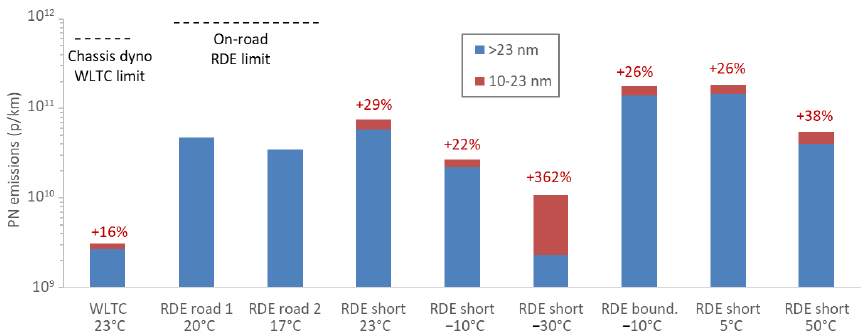
Figure 1. Particle number (PN) emissions for various cycles and ambient temperatures (in chronological order): Type 1 (WLTC), Type 1A on-road RDE (RDE road), RDE-like cycles tested on the chassis dynamometer (RDE short, RDE boundary). Dashed lines give the laboratory and on-road PN limits for this vehicle. RDE = real driving emissions; WLTC = worldwide harmonized light vehicles test cycle.